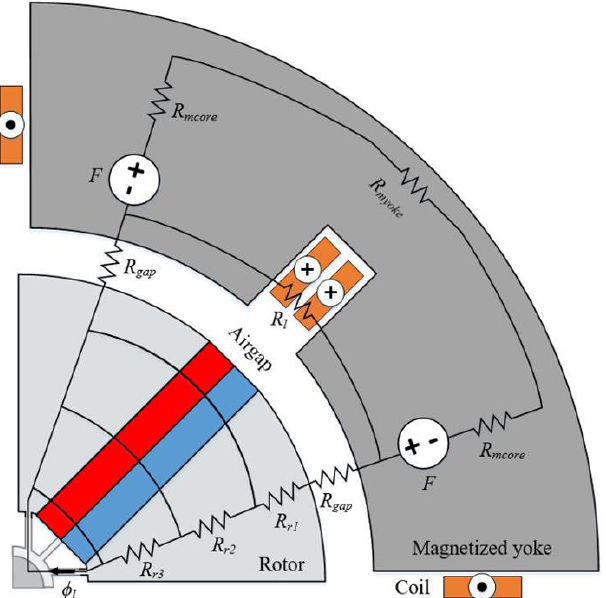
Figure 6. Magnetic equivalent circuit of the magnetizing yoke and spoke-type rotor.